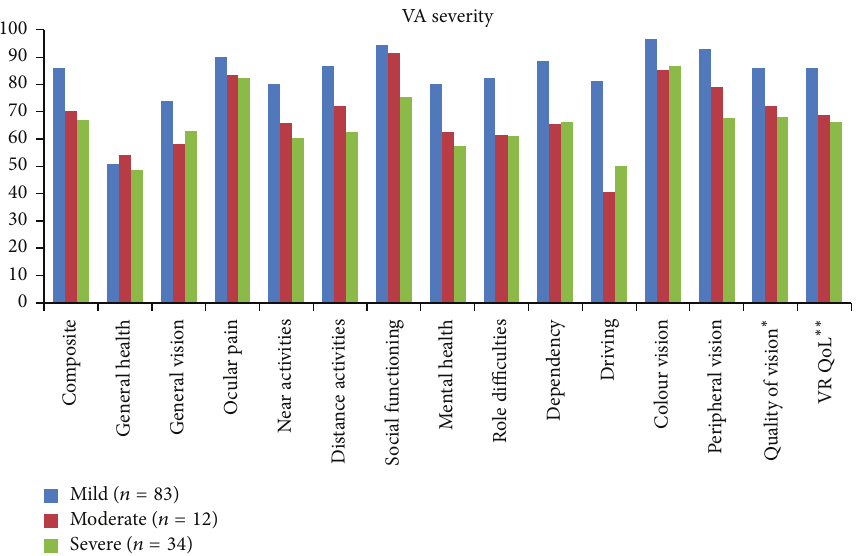
Figure 2: Mean NEI VFQ-25 scores at 6 months by visual acuity level. ∗ Mean of general vision, near activities, distance activities, peripheral vision, and colour vision subscales. ∗∗ Mean of driving, ocular pain, role difficulties, dependency, social functioning, and mental health subscales. VR Qol: vision-related quality of life.